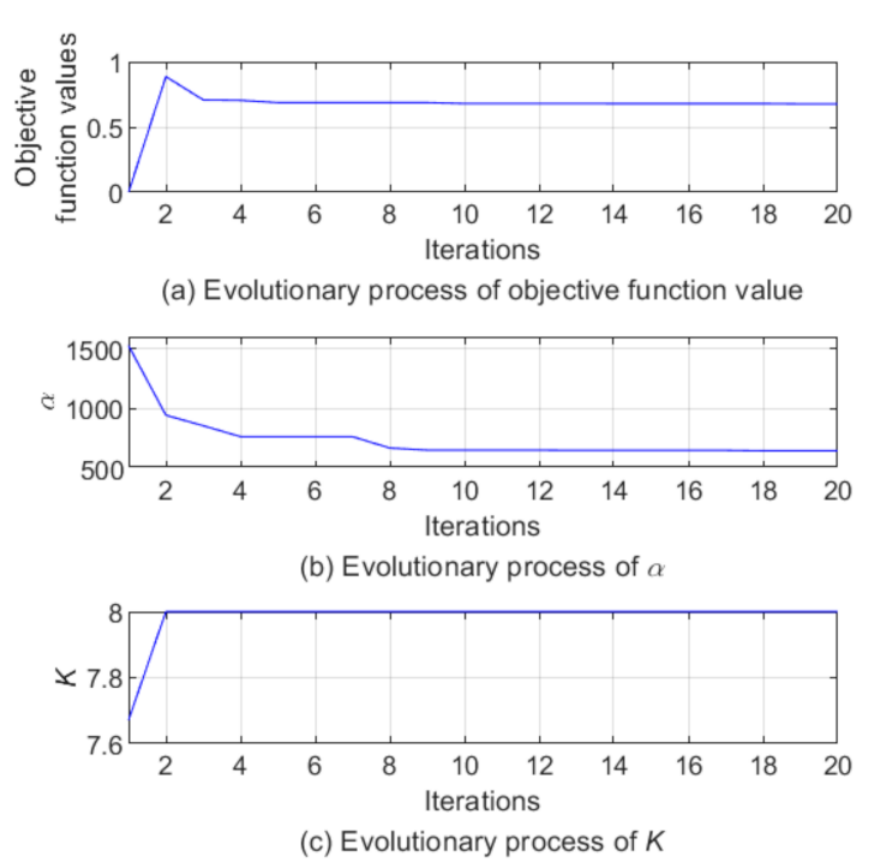
Figure 5. Evolutionary process of objective function values, K , and α during the GWO iteration.